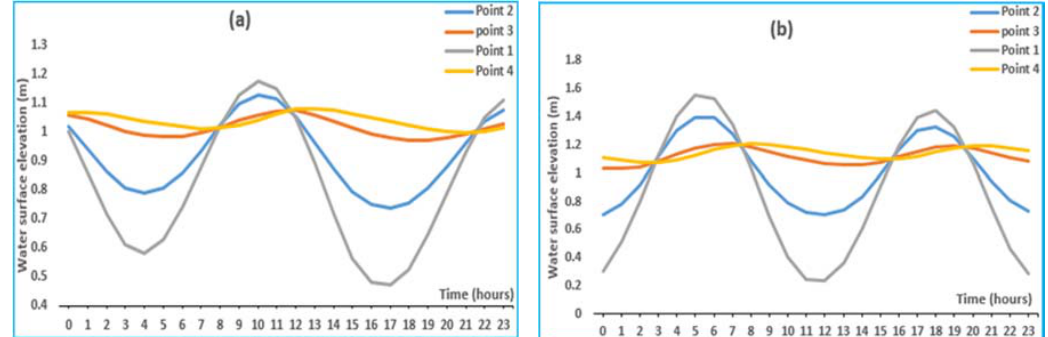
Figure 6. Variation of the water surface elevation simulated with average ( a ) and high ( b ) tidal amplitude in flood period.